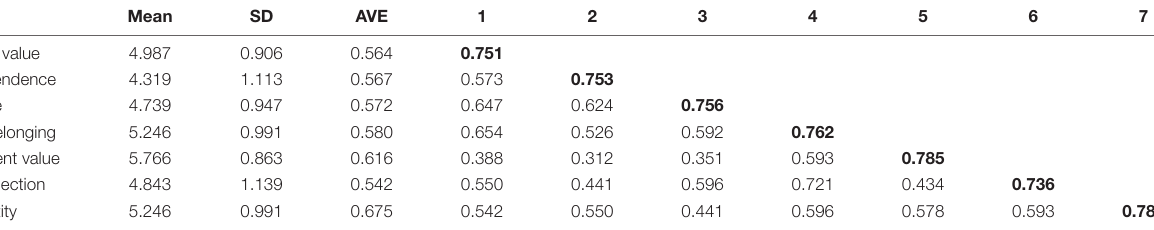
TABLE 2 | Discriminant validity for the measurement model. Variables